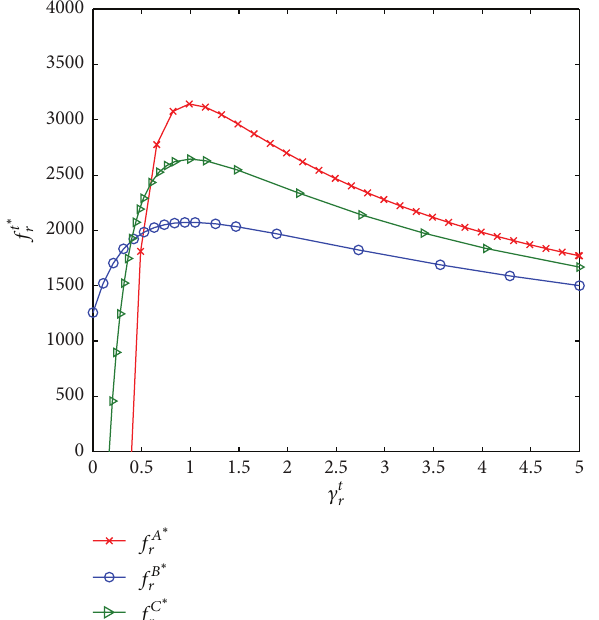
Figure 3: The profit of the manufacturer.